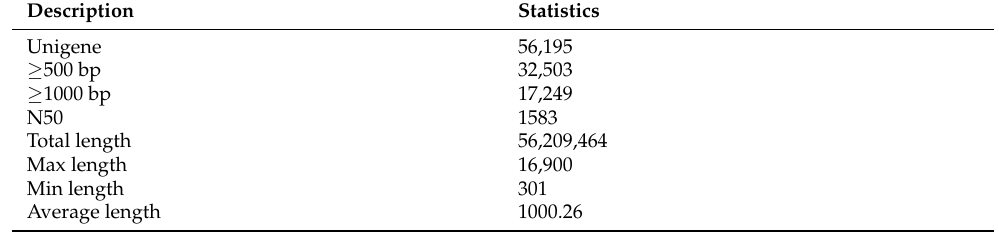
Table 2. RNA-sequencing data of Dioscorea spp.